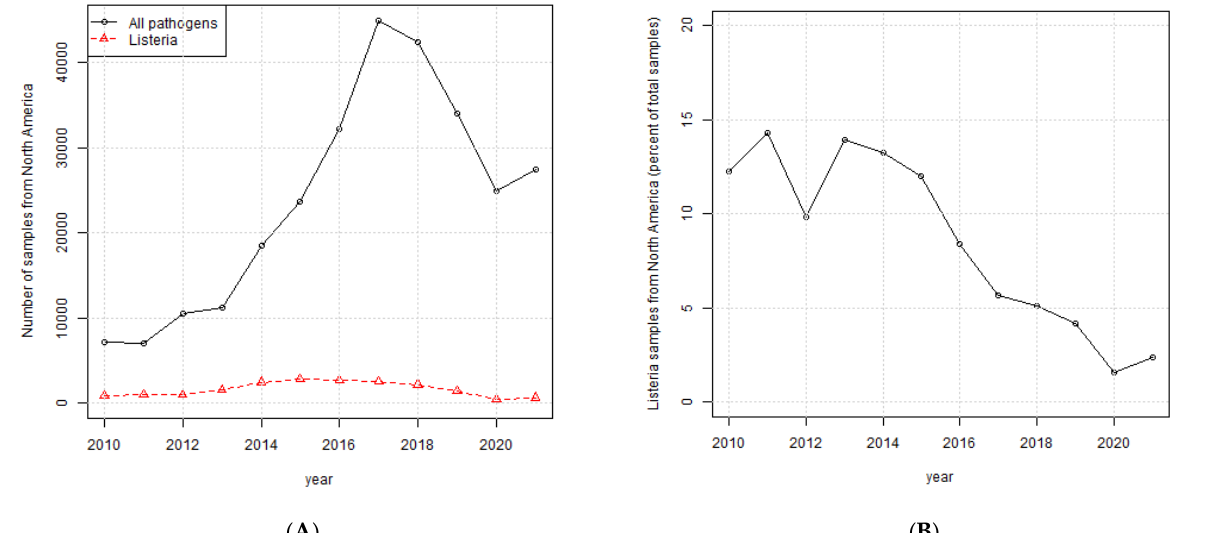
Figure 2. ( A ) Total number of samples from all pathogens and L. monocytogenes per year; ( B ) L. monocytogenes samples as a percentage of total pathogens per year.